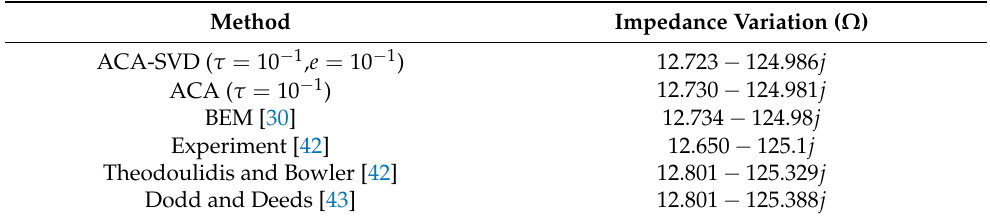
Table 3. Impedance variations predicted by ACA-SVD based BEM, analytical, semi-analytical methods and experiments for placing coil C27 above conducting plate B2.